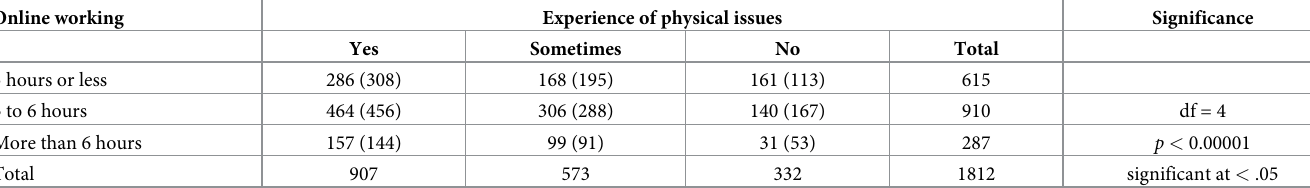
Table 2. Frequency of physical health issues experienced and number of online working hours. Online